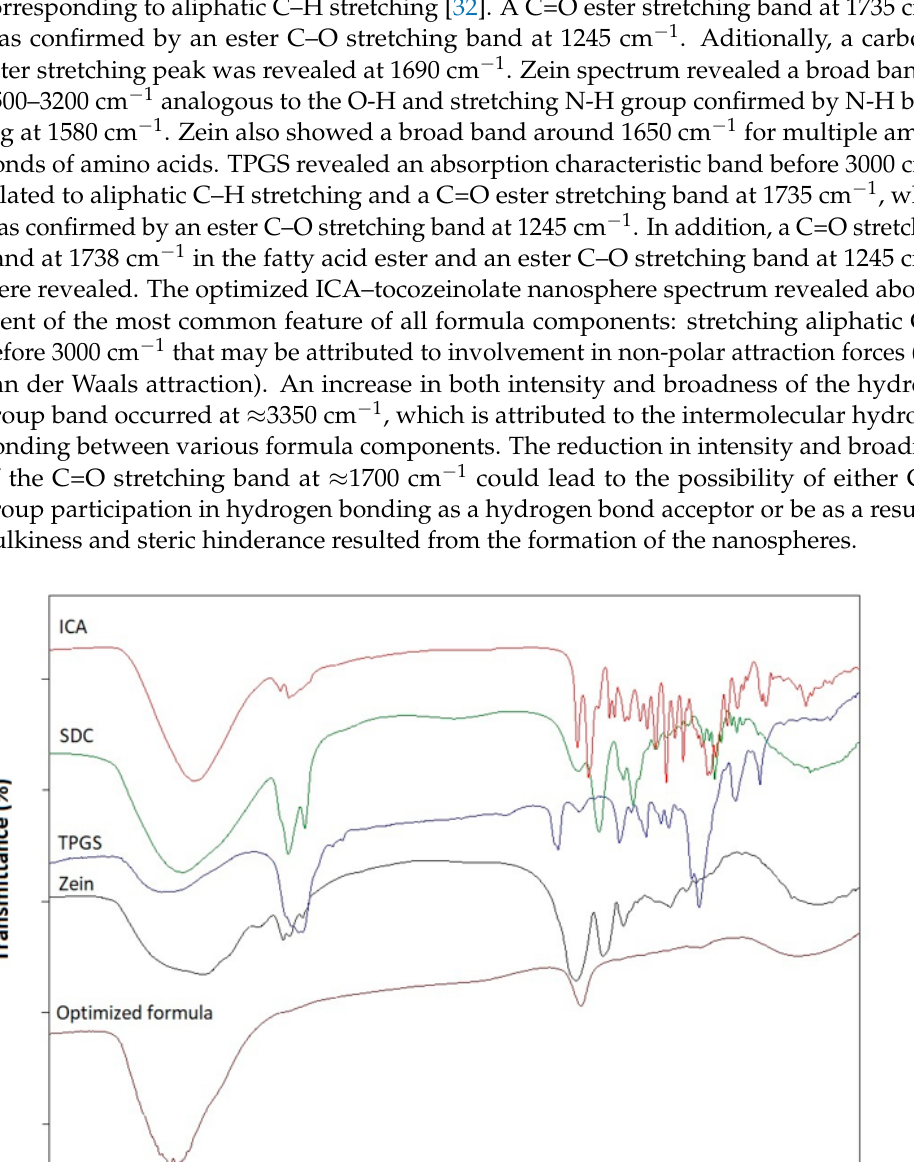
Figure 5. ( A ) Ramp graphs representing the optimized factor levels and the predicted responses for the optimized ICA–tocozeinolate nanospheres. ( B ) Desirability values for the predicted responses and overall desirability of the optimized ICA–tocozeinolate nanospheres.